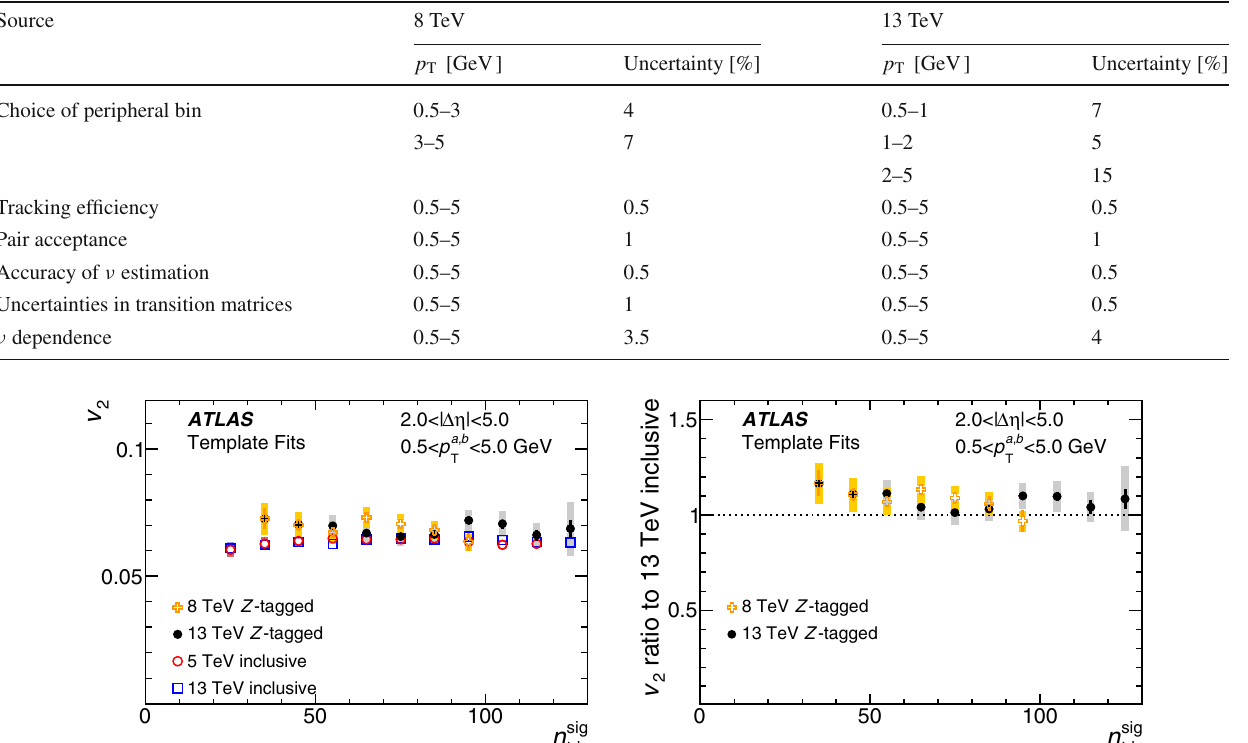
Fig. 11 Left panel: the pile-up-corrected v 2 values obtained from the templatefitsasafunctionof n sig .Forcomparison,the v 2 valuesobtained trk in5and13TeVinclusive pp datafromRef. [3]arealsoshown.Theerror bars and shaded bands indicate statistical and systematic uncertainties,